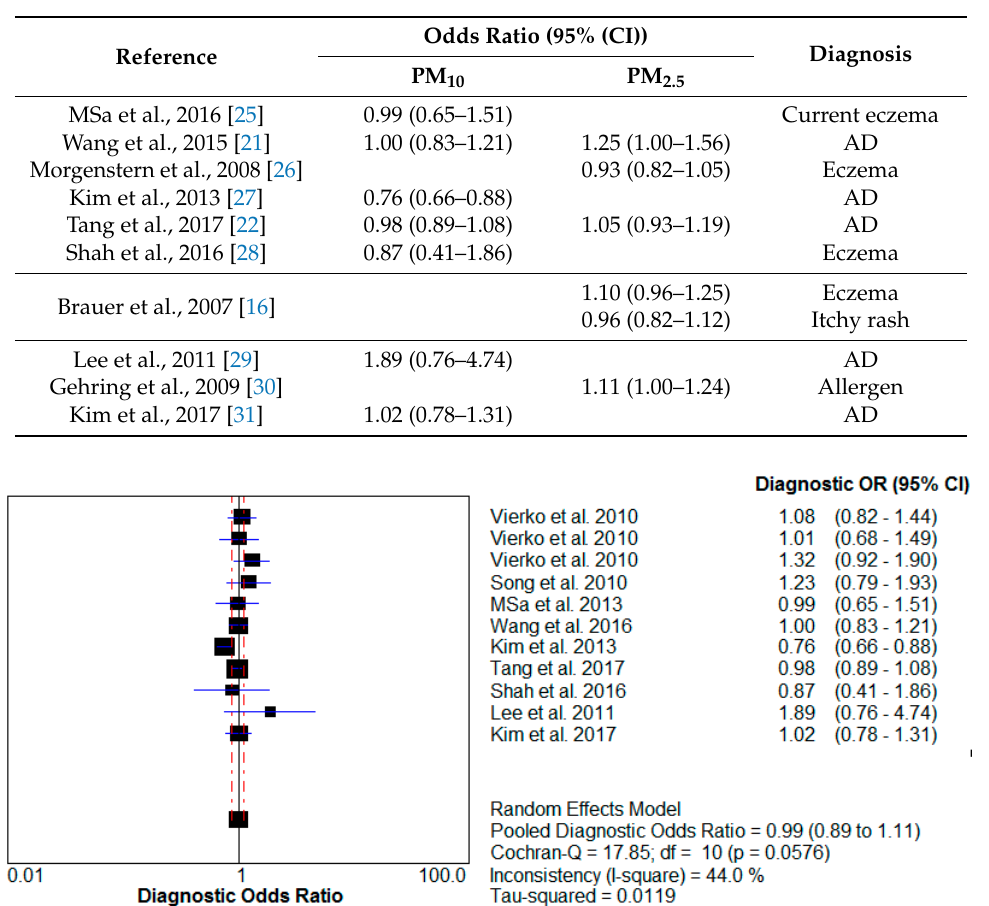
Figure 2. Relative risk of PM 10 impact on human skin. OR: odds ratio.